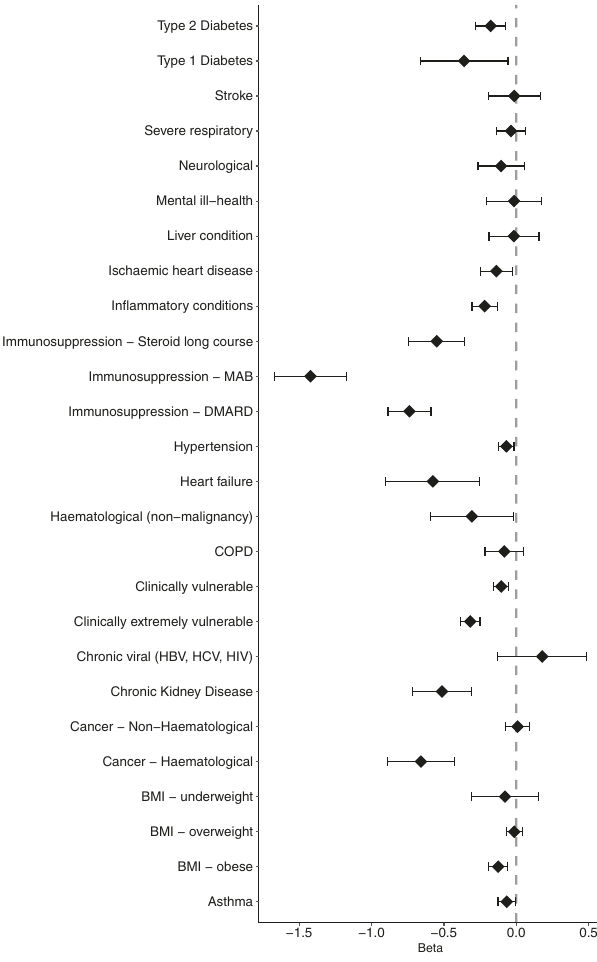
Fig. 2 | Dose 2 S-antibody levels linear regression forest plot. Beta coef fi cients and 95% con fi dence intervals, which are displayed as point estimates and asso- ciated error bars, derived from adjusted linear regression models for the effect of each clinical risk factor (investigated using a separate model) on log(n) S-antibody levels (U/ml) at ≥ 28 days after Dose 2. Each model controls for age, sex, ethnicity, vaccine type, dose interval and time since vaccination. Numbers included in each clinicalgroupareasfollows:Type2Diabetes n =411,Type1Diabetes n =46,Stroke n =131, Severe respiratory n =436, Neurological n =168, Mental ill-health n =119, Liver condition n =144, Ischaemic heart disease n =374, In fl ammatory conditions n =608, Immunosuppression Steroid long course n =114, Immunosuppression MAB n =67, Immunosuppression DMARD n =194, Hypertension n =2208, Heart failure n =40, Haematological (non-malignancy) n =52, COPD=244, Clinically vulnerable n =2319, Clinically extremely vulnerable n =1144, Chronic viral (HBV, HCV, HIV) n =45, Chronic kidney disease n =101, Cancer Non-Haematological n =666, Cancer Haematological n =80, BMI underweight n=82, BMI overweight n =2619, BMI obese n =1464, Asthma n =1375.